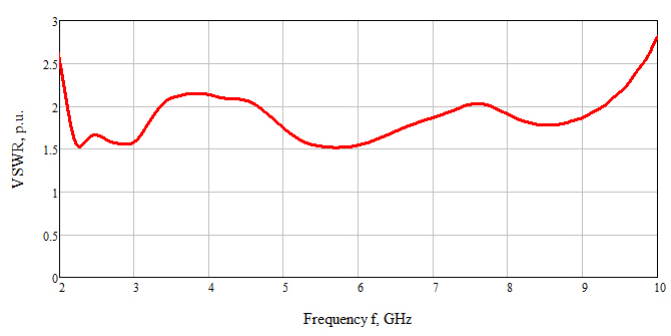
Figure 9. Dependence of voltage standing wave ratio on